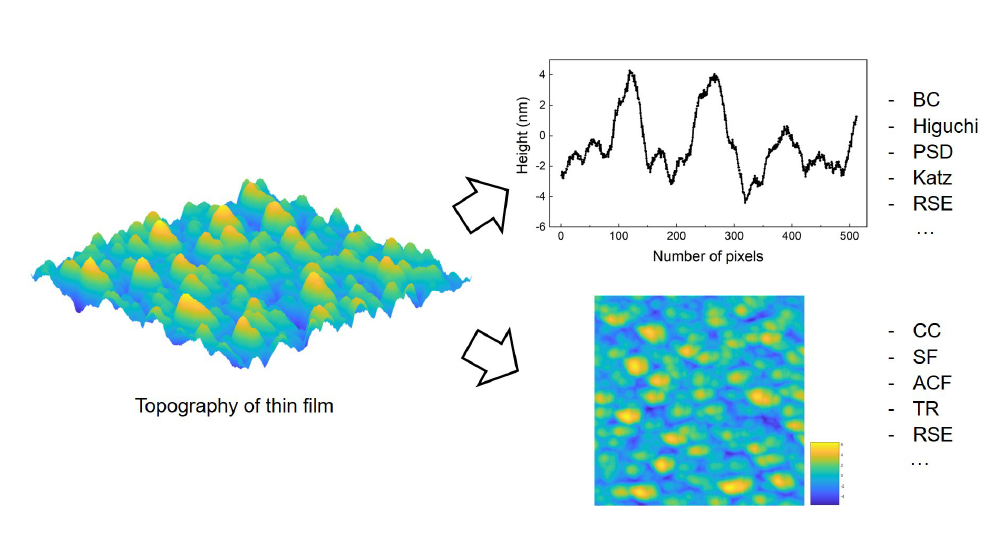
Figure 2. The fractal calculation methods of thin film surface based on profile or topographical image.